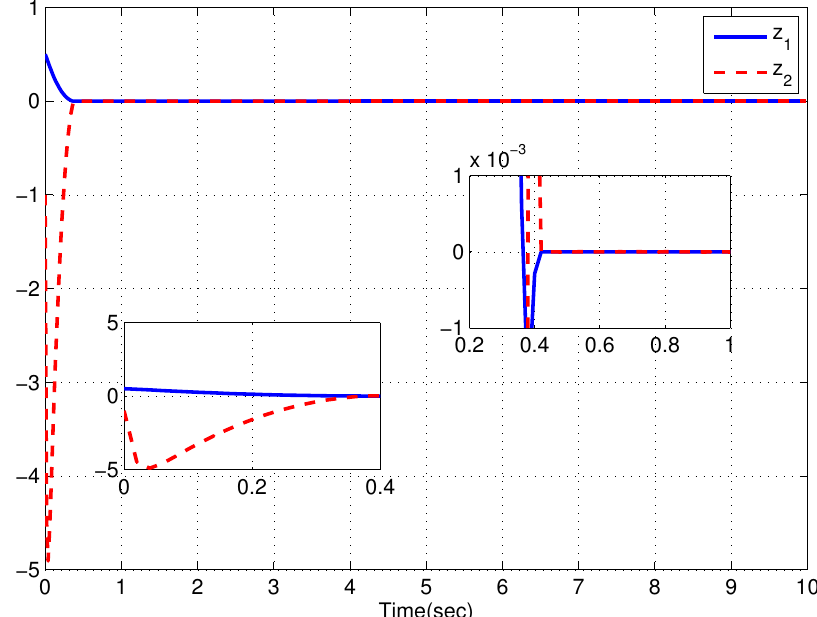
Figure 2. The state responses of the CLS with initial condition ( z 1 ( 0 ) , z 2 ( 0 )) = ( 0.5, − 1 ) .